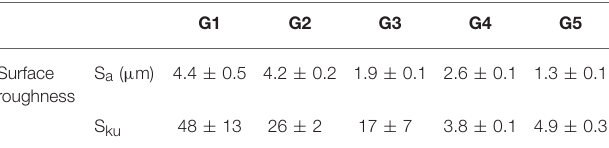
TABLE 2 | Surfaces roughness (S a and S ku ) experimentally measured on graphite grades.